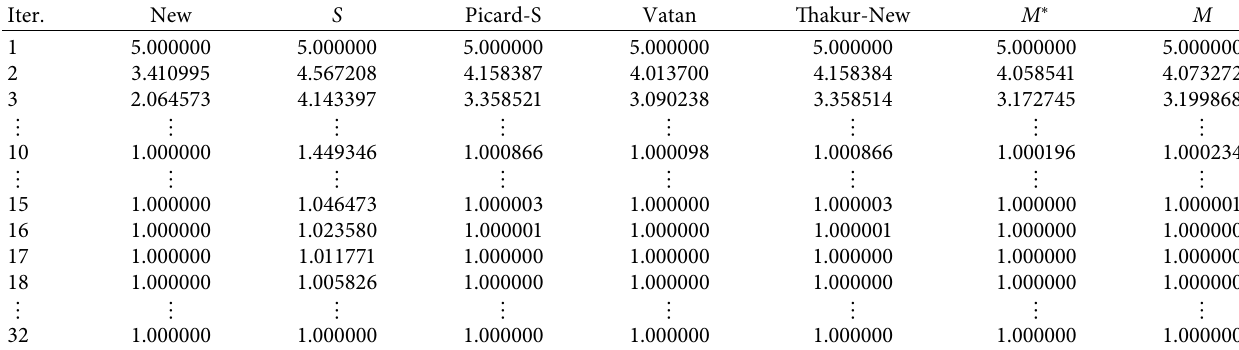
Table 1: A comparison table for the speed of convergence of iterative methods. Iter.